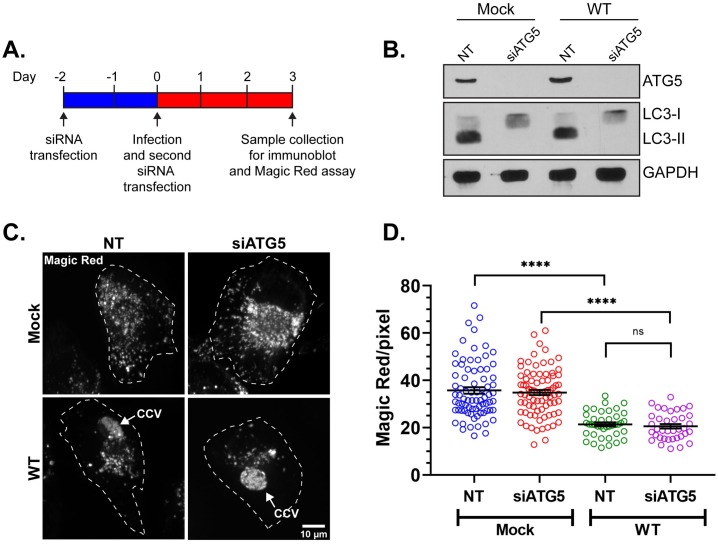
C. burnetii reduces lysosomes independent of autophagy.(A) Schematic diagram of dual siRNA transfection protocol in HeLa cells to suppress autophagy by ATG5 depletion. Cells were transfected with ATG5 siRNA (siATG5) or control non-targeting siRNA (NT) and incubated for 2 days, followed by C. burnetii infection and a second siRNA transfection. At 3 dpi cells were subjected to Magic Red assay or harvested for immunoblot analysis. (B) Immunoblot revealed that ATG5 protein was depleted by siATG5, resulting in decreased autophagy as demonstrated by a loss of LC3-II. (C) Representative images of cathepsin B Magic Red staining of mock and WT C. burnetii-infected HeLa cells transfected with NT or ATG5-specific siRNA. NT or siATG5 transfected and mCherry C. burnetii-infected cells were plated in ibidi slides and labeled with Magic Red for 30 min followed by live cell confocal microscopy. (D) Quantitation of Magic Red intensity, normalized to cell area, revealed no difference in cathepsin B activity between NT and siATG5-transfected cells regardless of C. burnetii infection. However as expected, there was a significant difference in cathepsin B activity between mock and WT-infected cells. Each circle represents an individual cell. Data shown as mean±SEM of at least 20 cells per condition in each of three independent experiments as analyzed by one-way ANOVA; ****, P<0.0001; ns, non-significant.